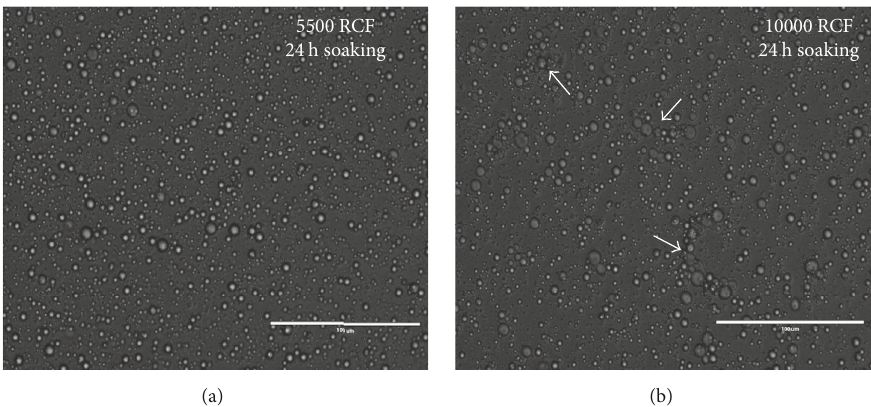
Figure 8: Light micrographs of crude oil body (COBs) emulsions of pecan nuts recovered using (a) 5500 RCF and (b) 10000RCF. The arrows indicate aggregations. The scale bars represent 100 𝜇 m.